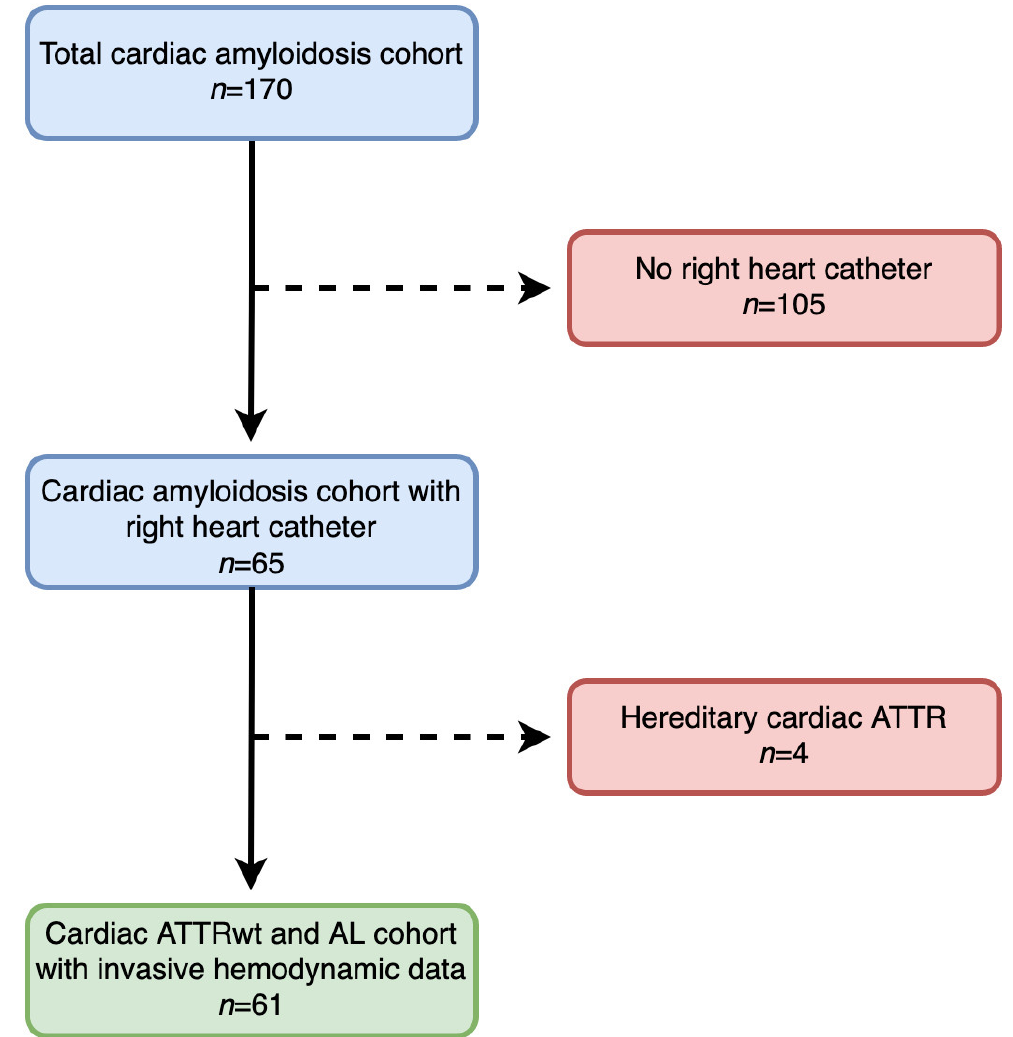
Figure 1. Patient flow-chart. A total of 170 patients were screened for the study. Reasons for exclusion are displayed. Transthyretin amyloidosis (ATTR); wild-type transthyretin amyloidosis (ATTRwt); light-chain amyloidosis (AL). Table 1. Baseline characteristics.